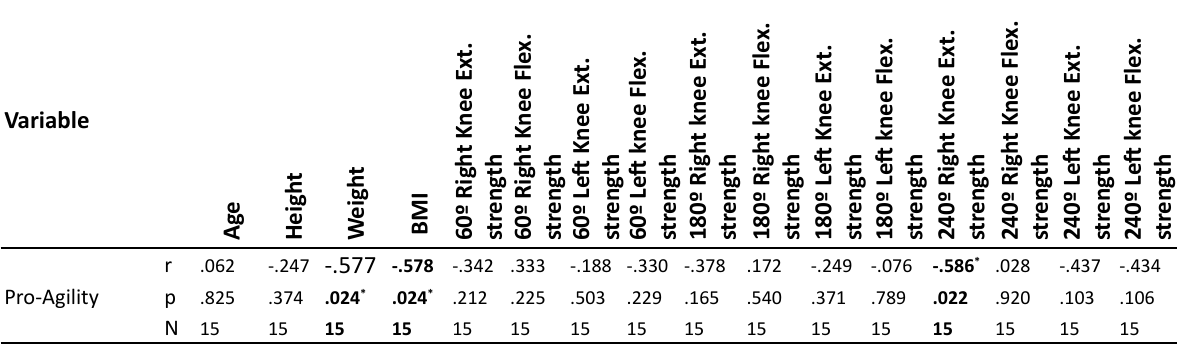
Table 4. The association between descriptive parameters and isokinetic knee strength and agility